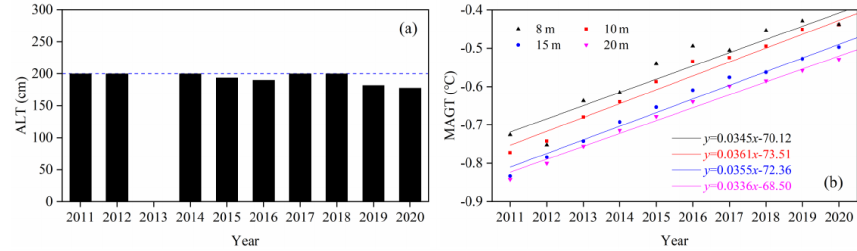
Figure 6. Variations in the (a) active layer thickness (ALT) and (b) mean annual ground temperature (MAGT) in borehole JB-B-II at the JB site along the China–Russia crude oil pipeline (CRCOP) I in the northern part of Northeast China from 2011 to 2020.